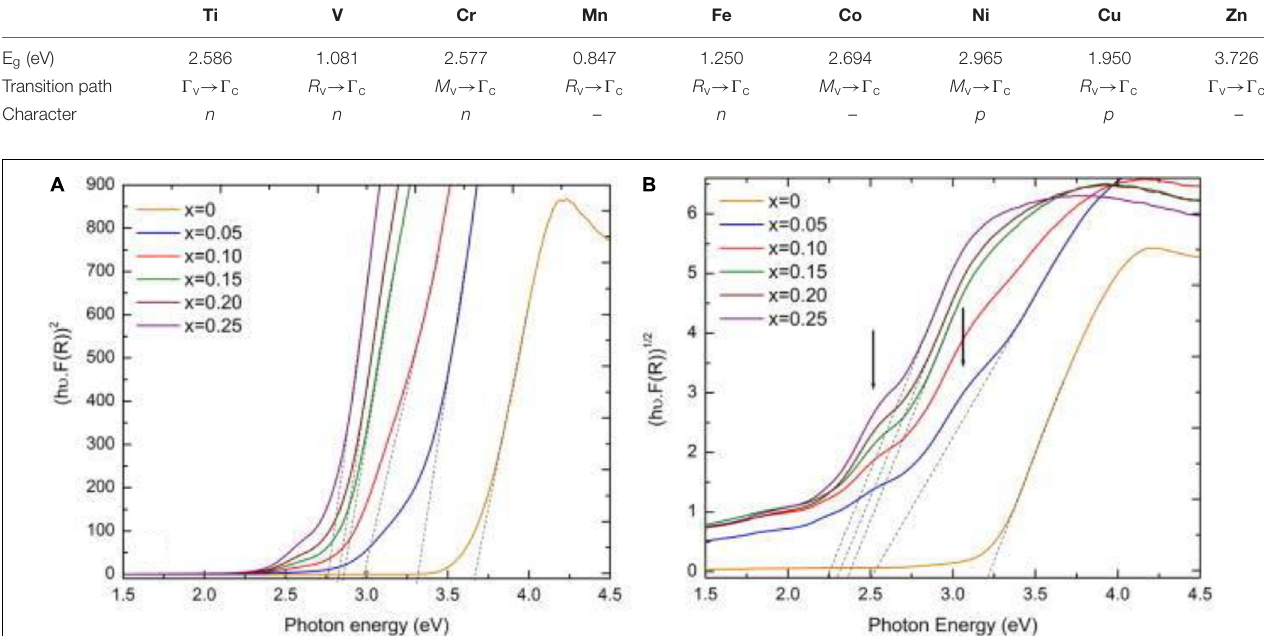
TABLE 4 | Summary of bandgap, transition path, gap character for KN doped with BaNb 2 / 3 B (cid:48) 1 / 3 O 3 , where B (cid:48) is a 3d transition metal. [After Liang and Shao (2019)].